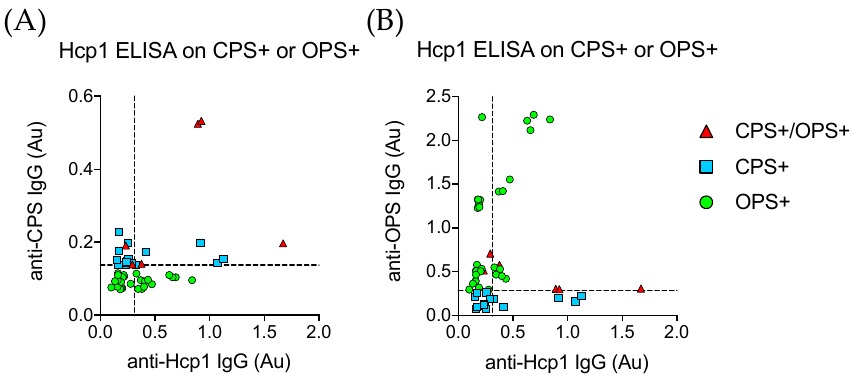
Figure 3. Hcp1 ELISA on Hoa Binh and CPS +/ OPS + Samples. ( A ) The anti-CPS IgG ELISA absorbance values of all samples passing cutoff in either the CPS or OPS ELISA compared to the measured absorbance in the anti-Hcp1 IgG ELSA. Dashed lines on each axis represent the cutoff values for their respective assays. ( B ) The anti-OPS IgG ELISA absorbance values of all samples passing cutoff in either the CPS or OPS ELISA compared to the measured absorbance in the anti-Hcp1 IgG ELSA. Dashed lines on each axis represent the cutoff values for their respective assays. Red triangles are samples that were positive for CPS and OPS assays. Light blue squares are samples positive in only the CPS assay, and green circles are only positive in the OPS assay.